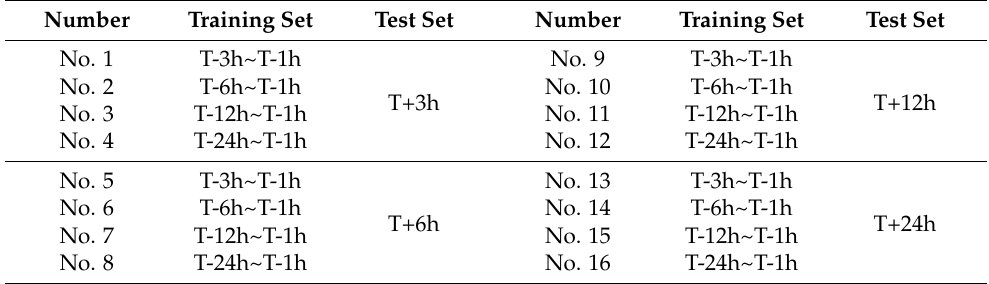
Table 6. The sequence number and division methods of each combination of training set and corresponding test